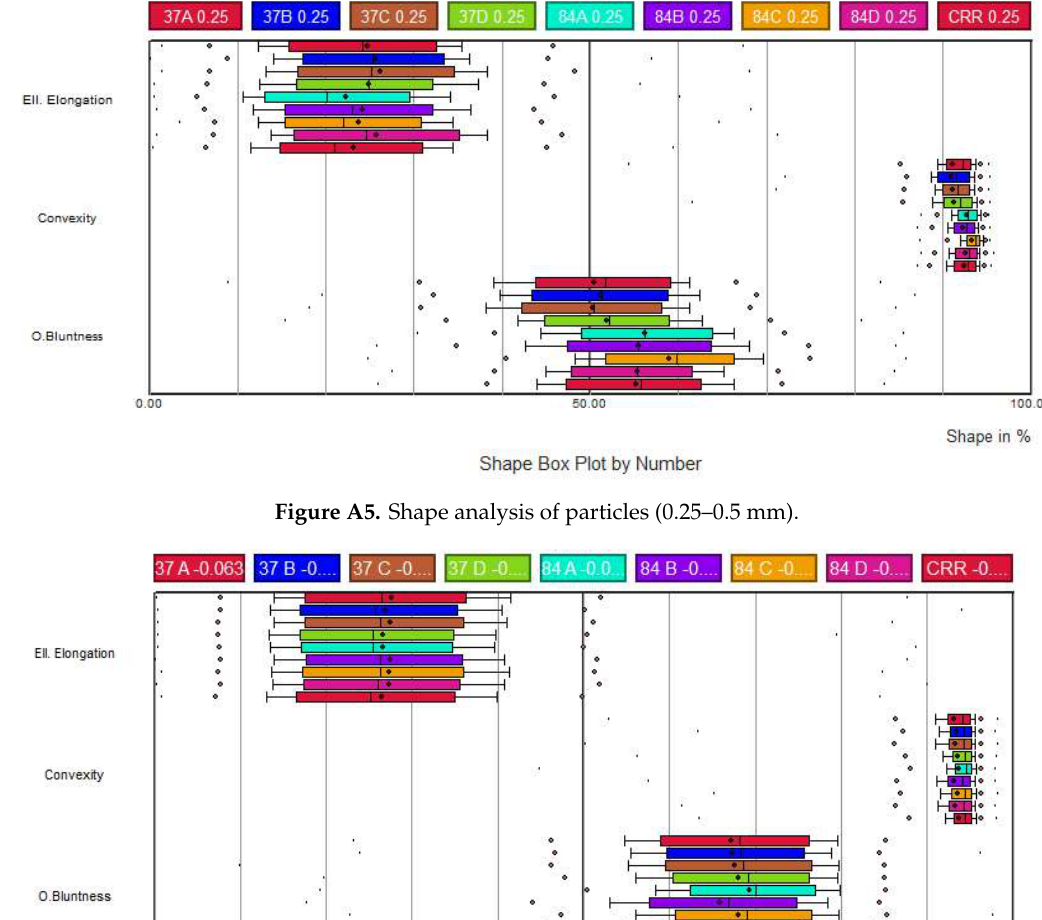
Figure A4. Shape analysis of particles (0.5–1 mm).